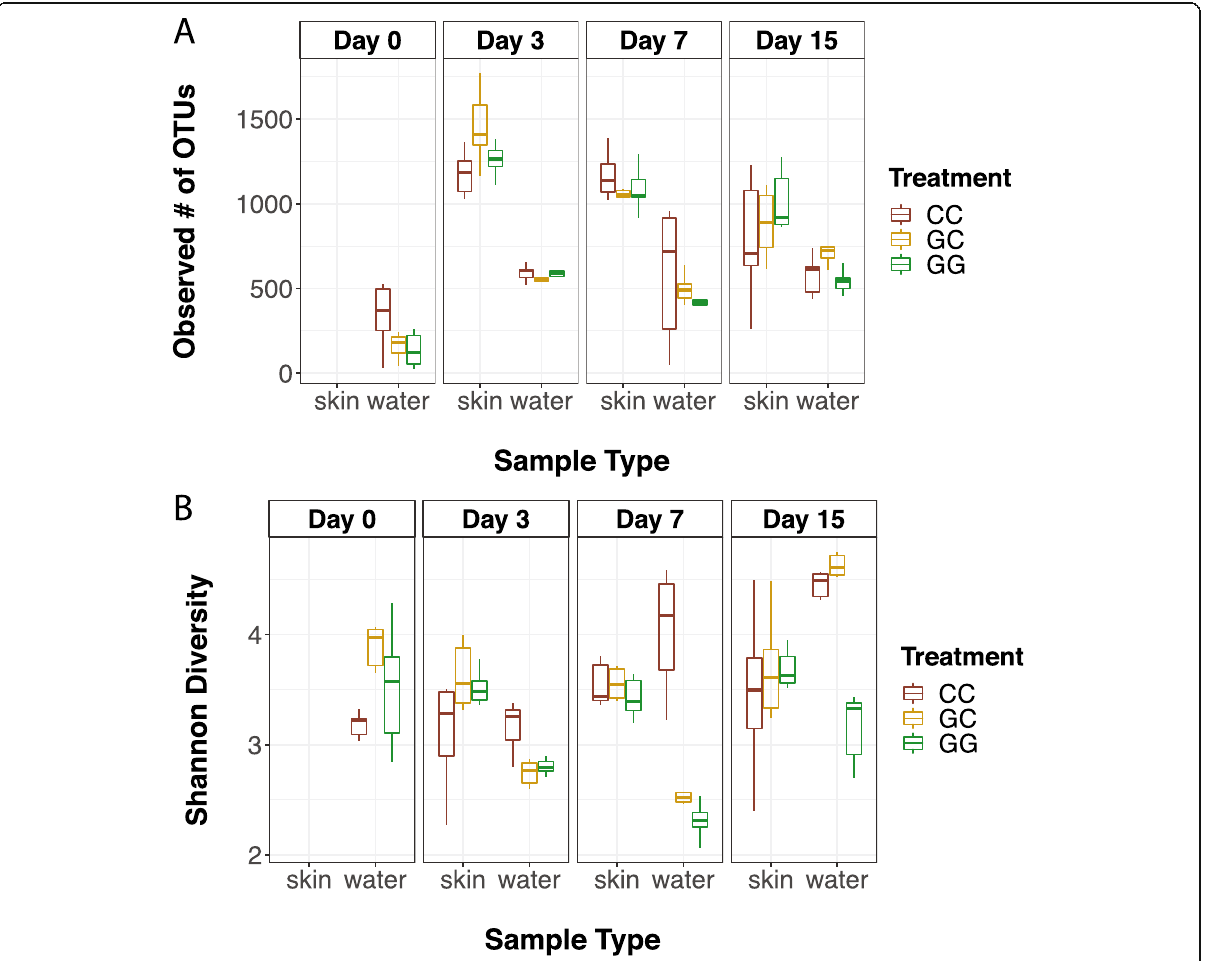
Fig. 3 Effects of treatment and date on ( a ) the observed number of OTUs and ( b ) Shannon diversity of microbial communities on larval sablefish skin and in experimental tank water. Samples from larval skin were not taken on day 0. (For each date and sample type, n = 6 per treatment). CC = claywater for 15 days. GC = greenwater with a switch to claywater after 1 week. GG = greenwater for 15 days. Box plots represent median values with lower and upper hinges corresponding to the first and third